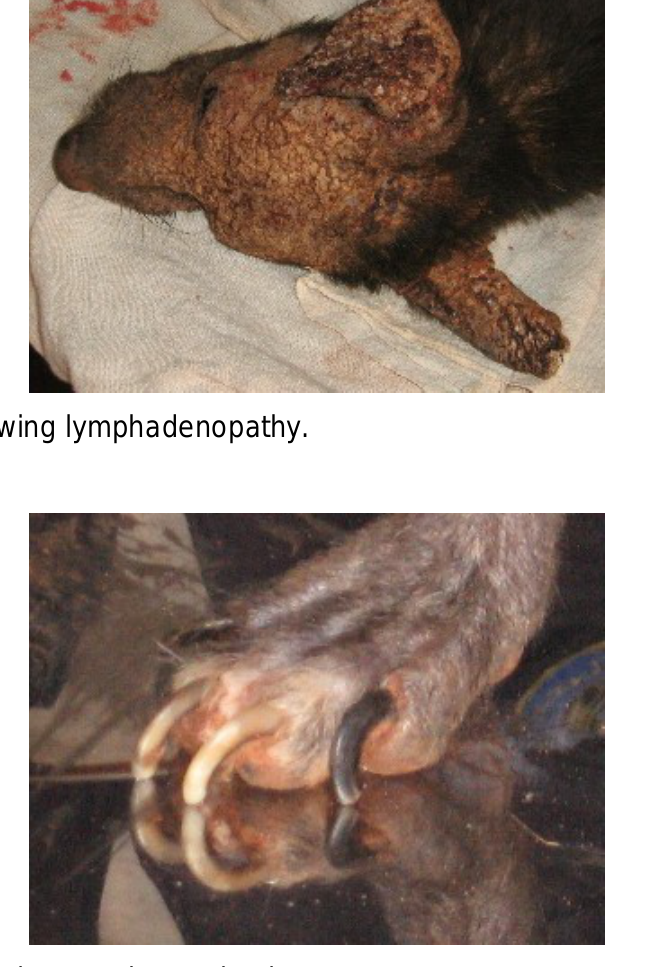
Figure 3. Dog showing onychogryphosis.